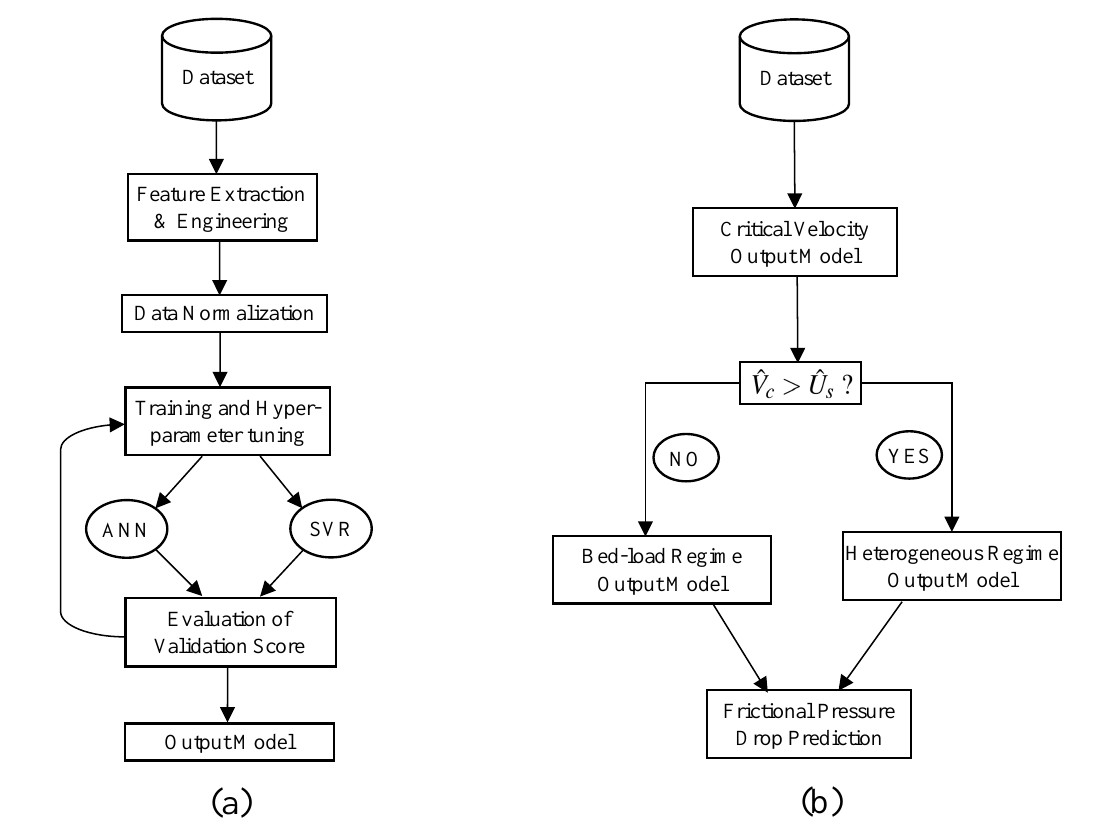
Figure 4. The work-flow charts for ( a ) obtaining the most generalized model corresponding to each dataset and ( b ) an integrated method for prediction of the slurry friction